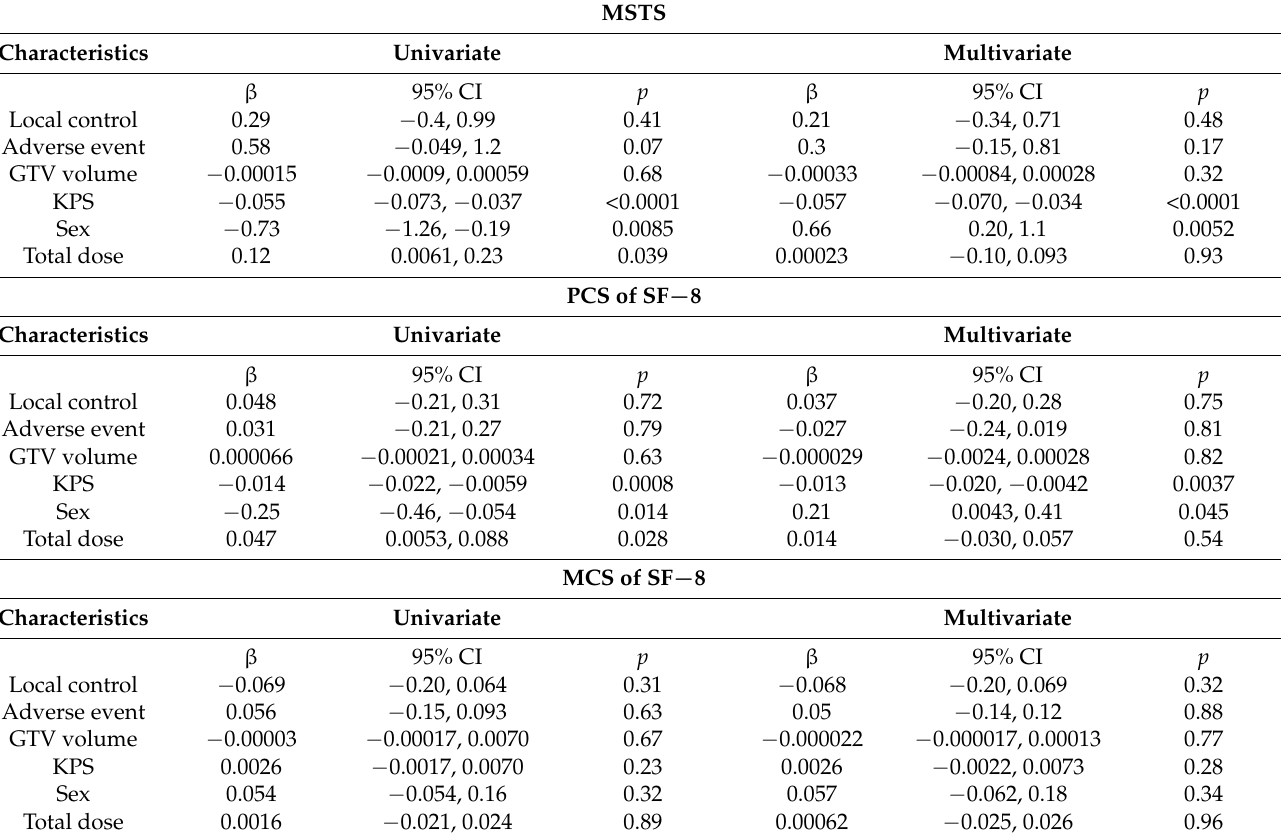
Table 3. Predictive factors for the normalized scores determined using uni- and multivariate